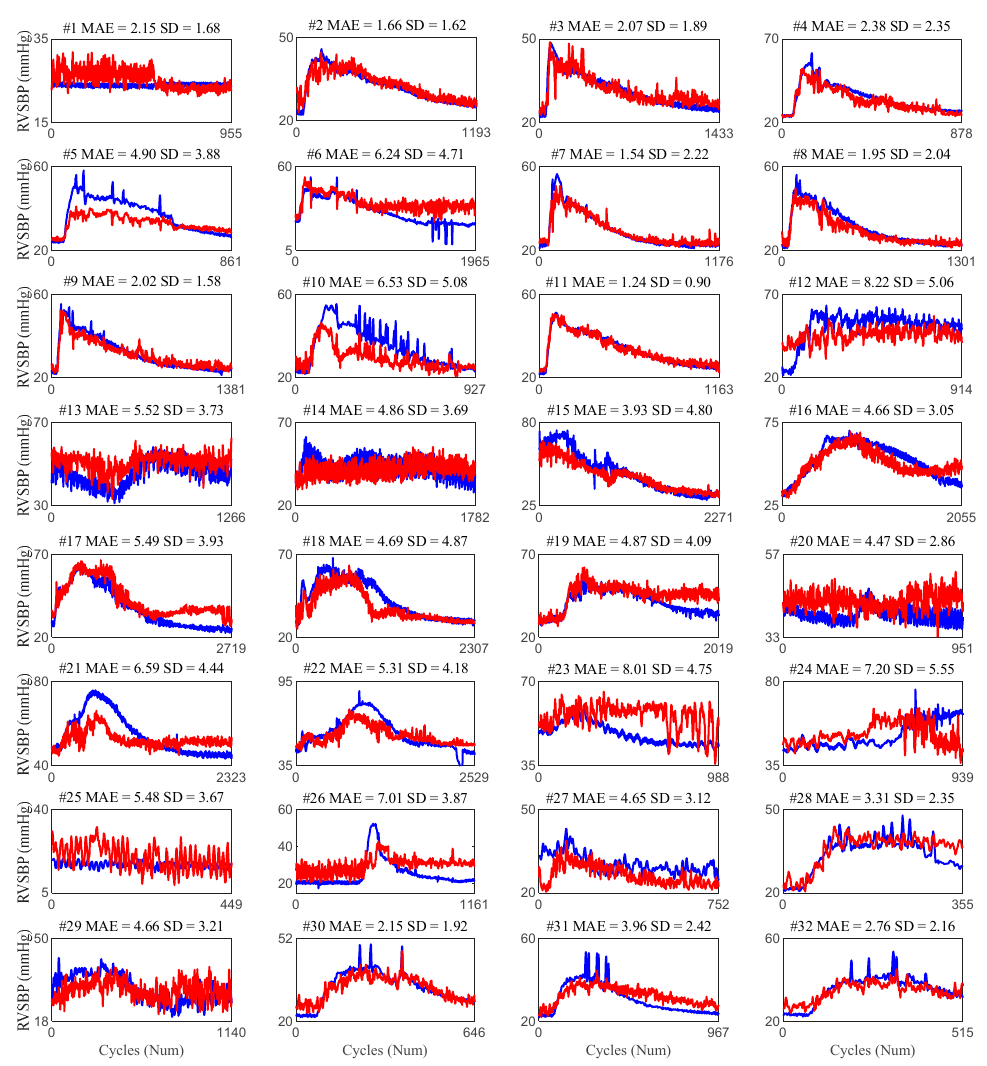
Figure 7. Performance of scheme II.